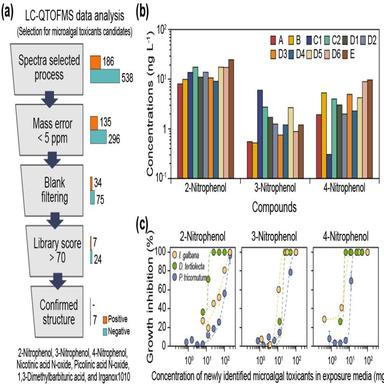
(a) Selection criteria for the identification of microalgal toxicants. (b) Distribution of newly identified microalgal toxicants in sediments from Ulsan Bay. (c) Dose-response relationships between concentrations of n-NPs and growth inhibitions of the three microalgae (Isochrysis galbana, Dunaliella tertiolecta, and Phaeodactylum tricornutum).